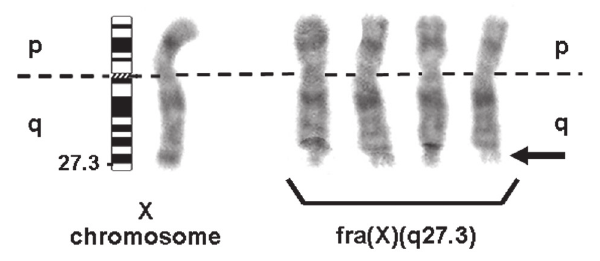
figurE − Partial GTG-Banding karyotypes (≥ 550 bands) showing a normal X and fragile X [fra(X)(q27.3)] chromosomes GTG: G-bands after trypsin and Giemsa; p: short arm; q: long